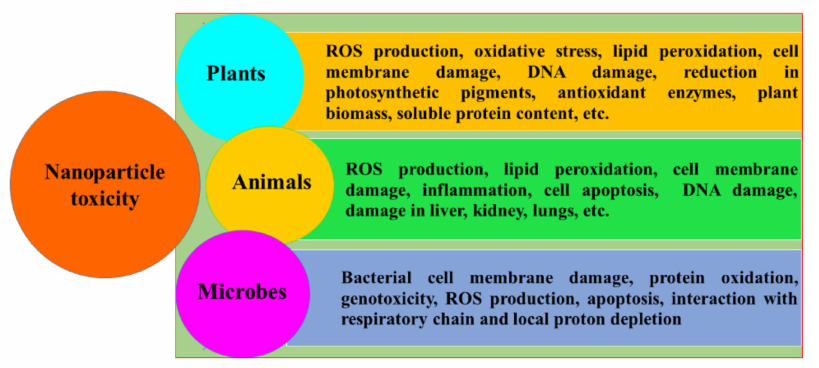
Figure 7. Toxicity effects of NPs on microbes, plants, and